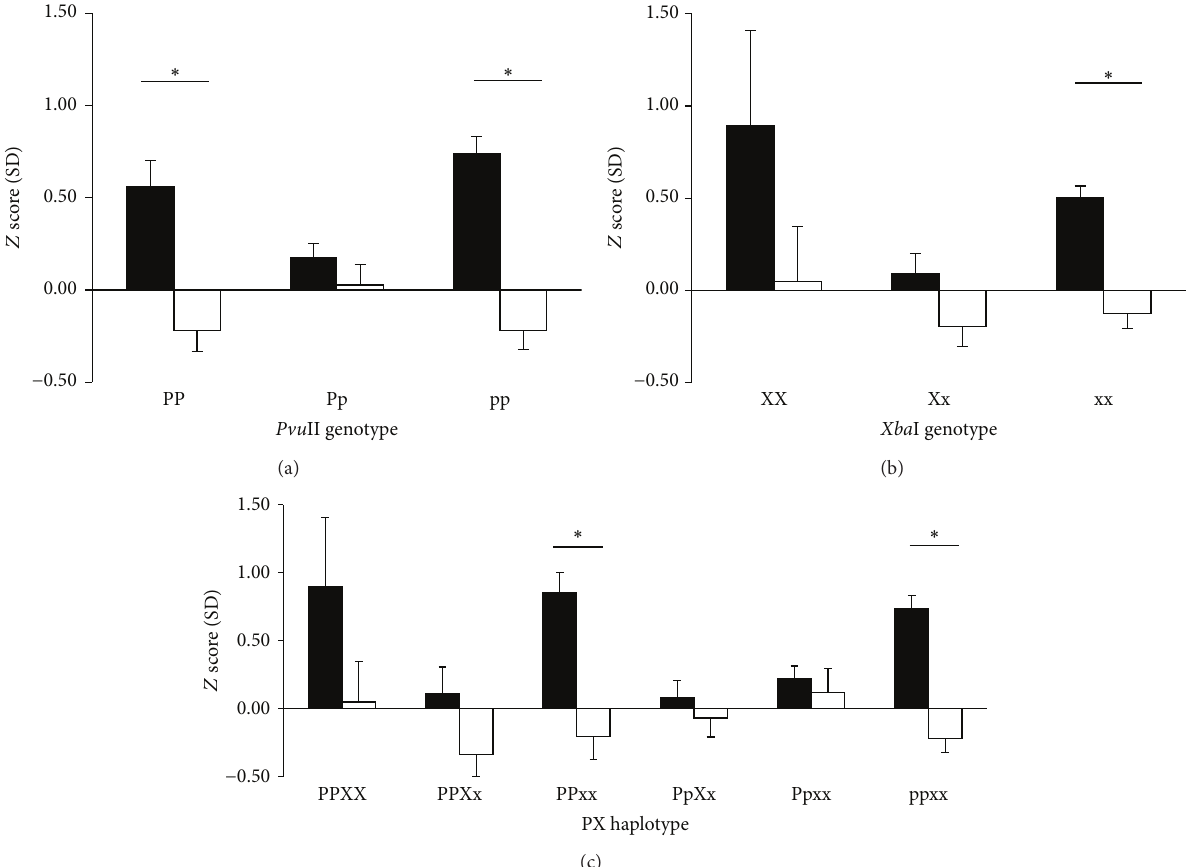
Figure 2: The exercise effect on bone density 𝑍 scores classified by Pvu II and Xba I RFLP genotypes and haplotypes. Values are expressed as mean ± SEM.Thezerolineisequaltotheage-basedmeanvalue.Solidandopenbarsindicatetheexerciseandnonexercisegroups,respectively. ∗ 𝑃 < 0.05 compared between the exercise and nonexercise groups in each ER 𝛼 genotype and haplotype. (a) The mean 𝑍 score in the PP or pp genotype with exercise was significantly higher than that without exercise. (b) The 𝑍 score in the exercise group with xx genotypes was significantly higher than that of the nonexercise group. (c) The 𝑍 score in the exercise group with PPxx or ppxx genotype was significantly higher than that of the nonexercise group. The difference of habitual exercise in bone density was minimal in PpXx and